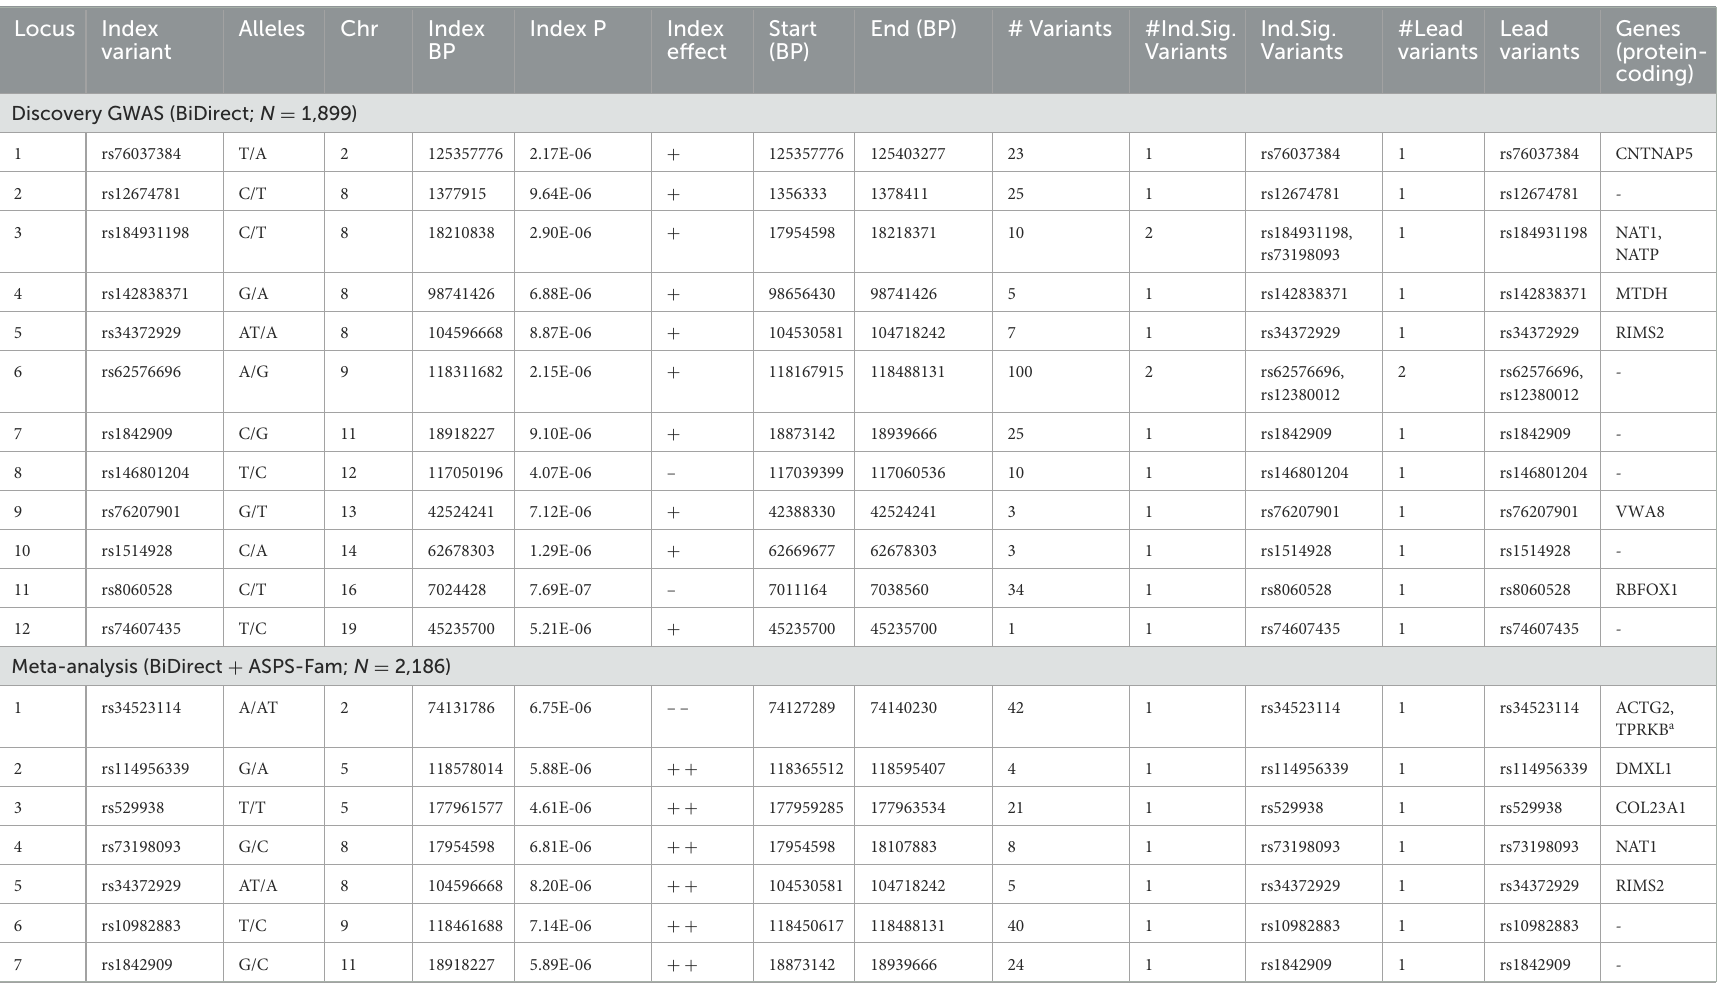
TABLE 2 Suggestive genomic loci for sNfL measures in BiDirect and the meta-analysis with